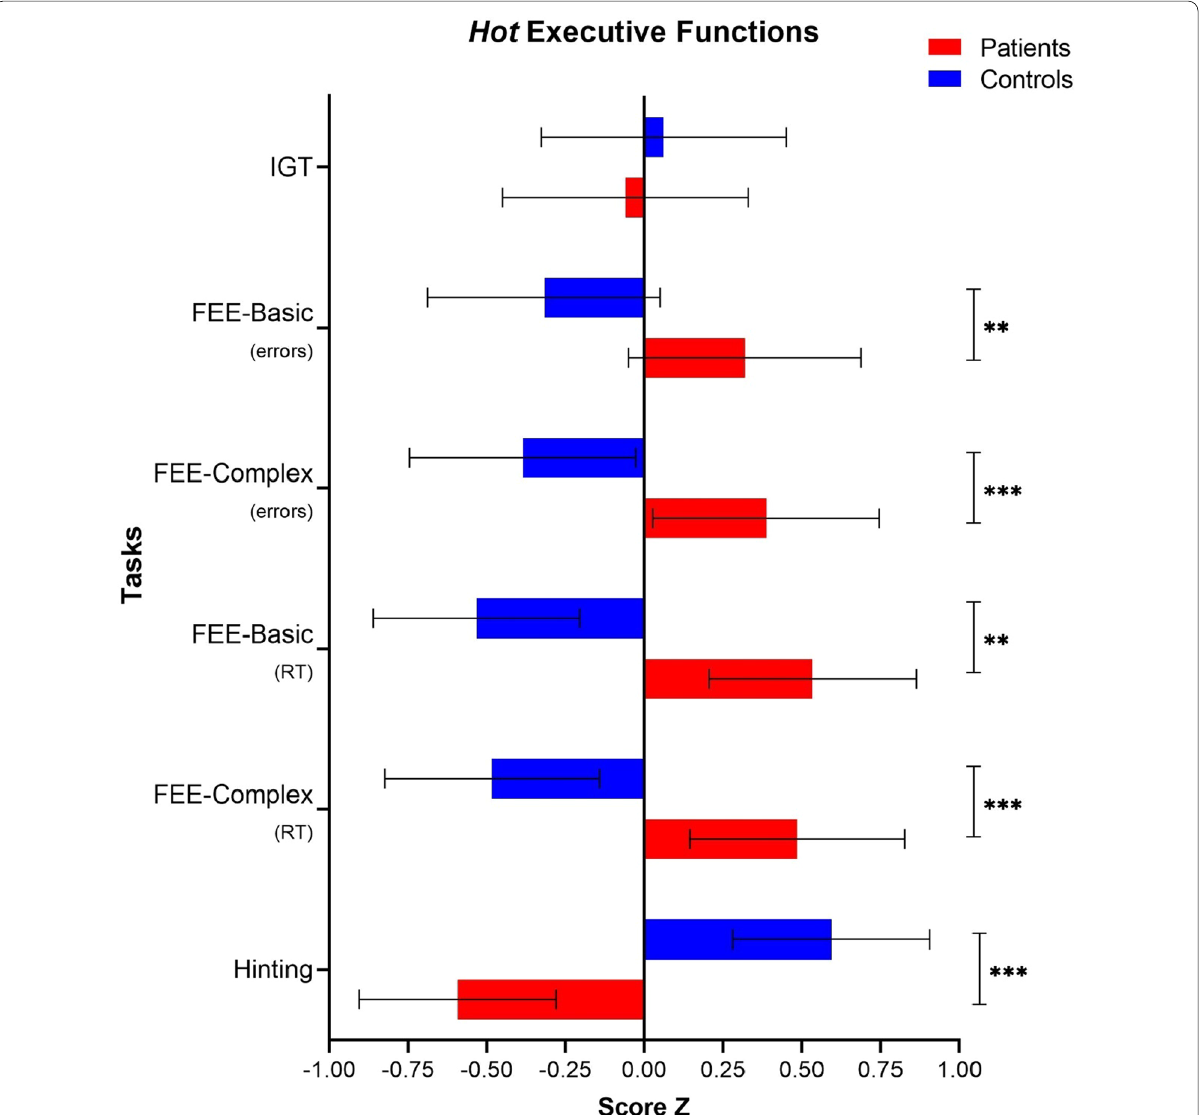
Fig. 3 Hot EEFF compared between patients and controls. Note : IGT time. * p < 0.05. ** p < 0.01. *** p <